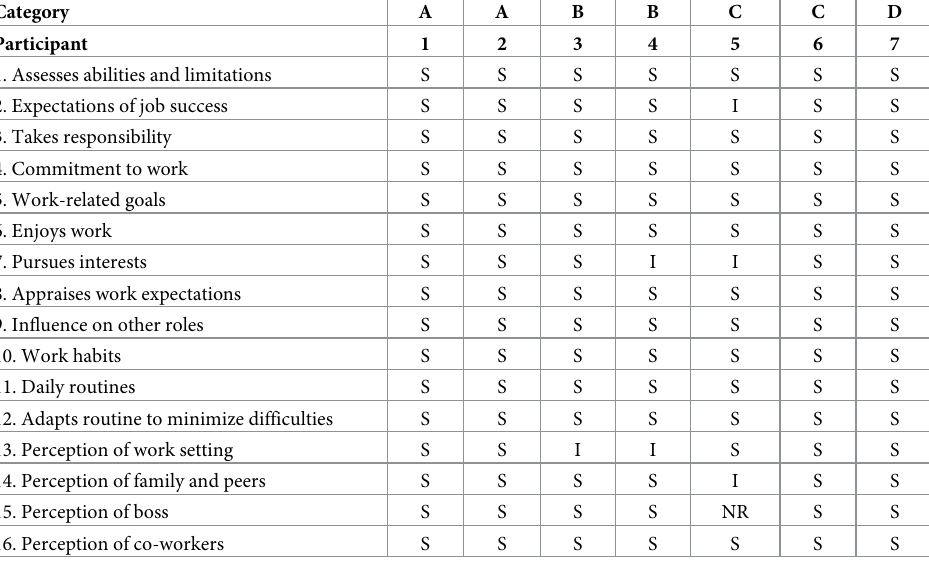
Table 6. Rating for each item on The Worker Role Interview (WRI) in the four categories of the participants (n = 7).